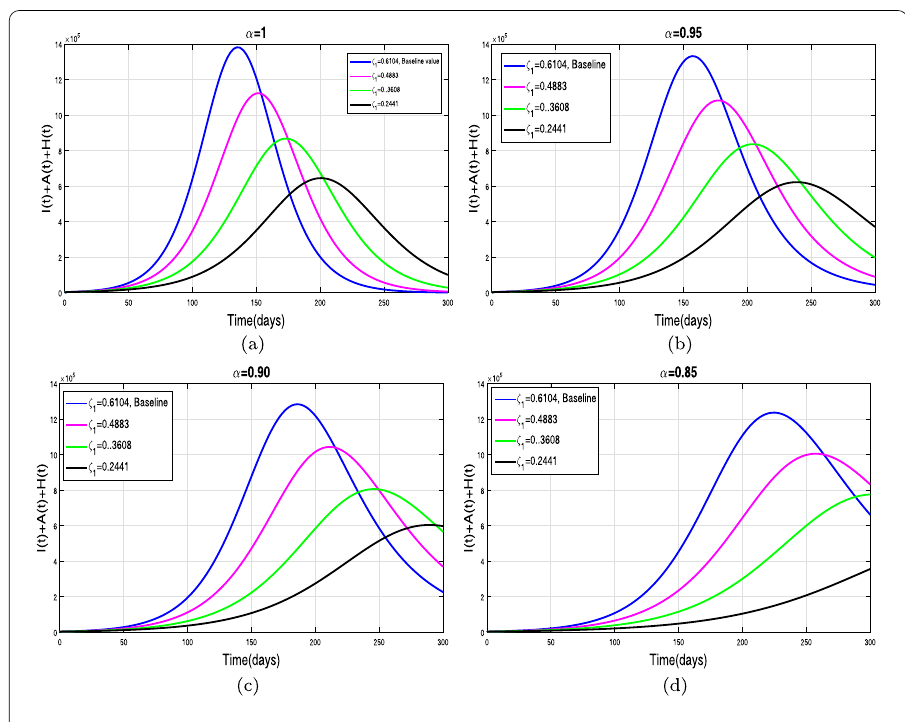
Figure 2 The impact of contact rate ζ 1 on cumulative symptomatic, asymptomatic, and hospitalized COVID-19 individuals for α = 1, α = 0.95, α = 0.90, α = 0.85